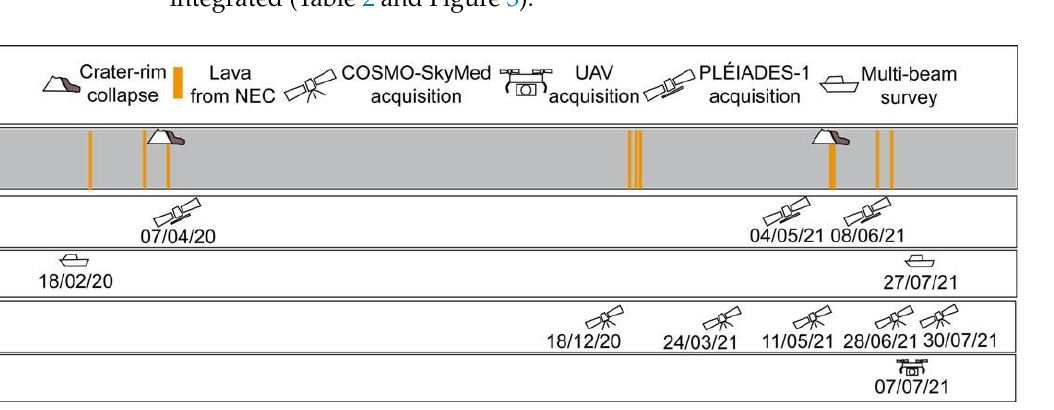
Figure 3. Chronology of data acquisition between February 2020 and July 2021 and main eruptive events in the same period (see also Table 2).